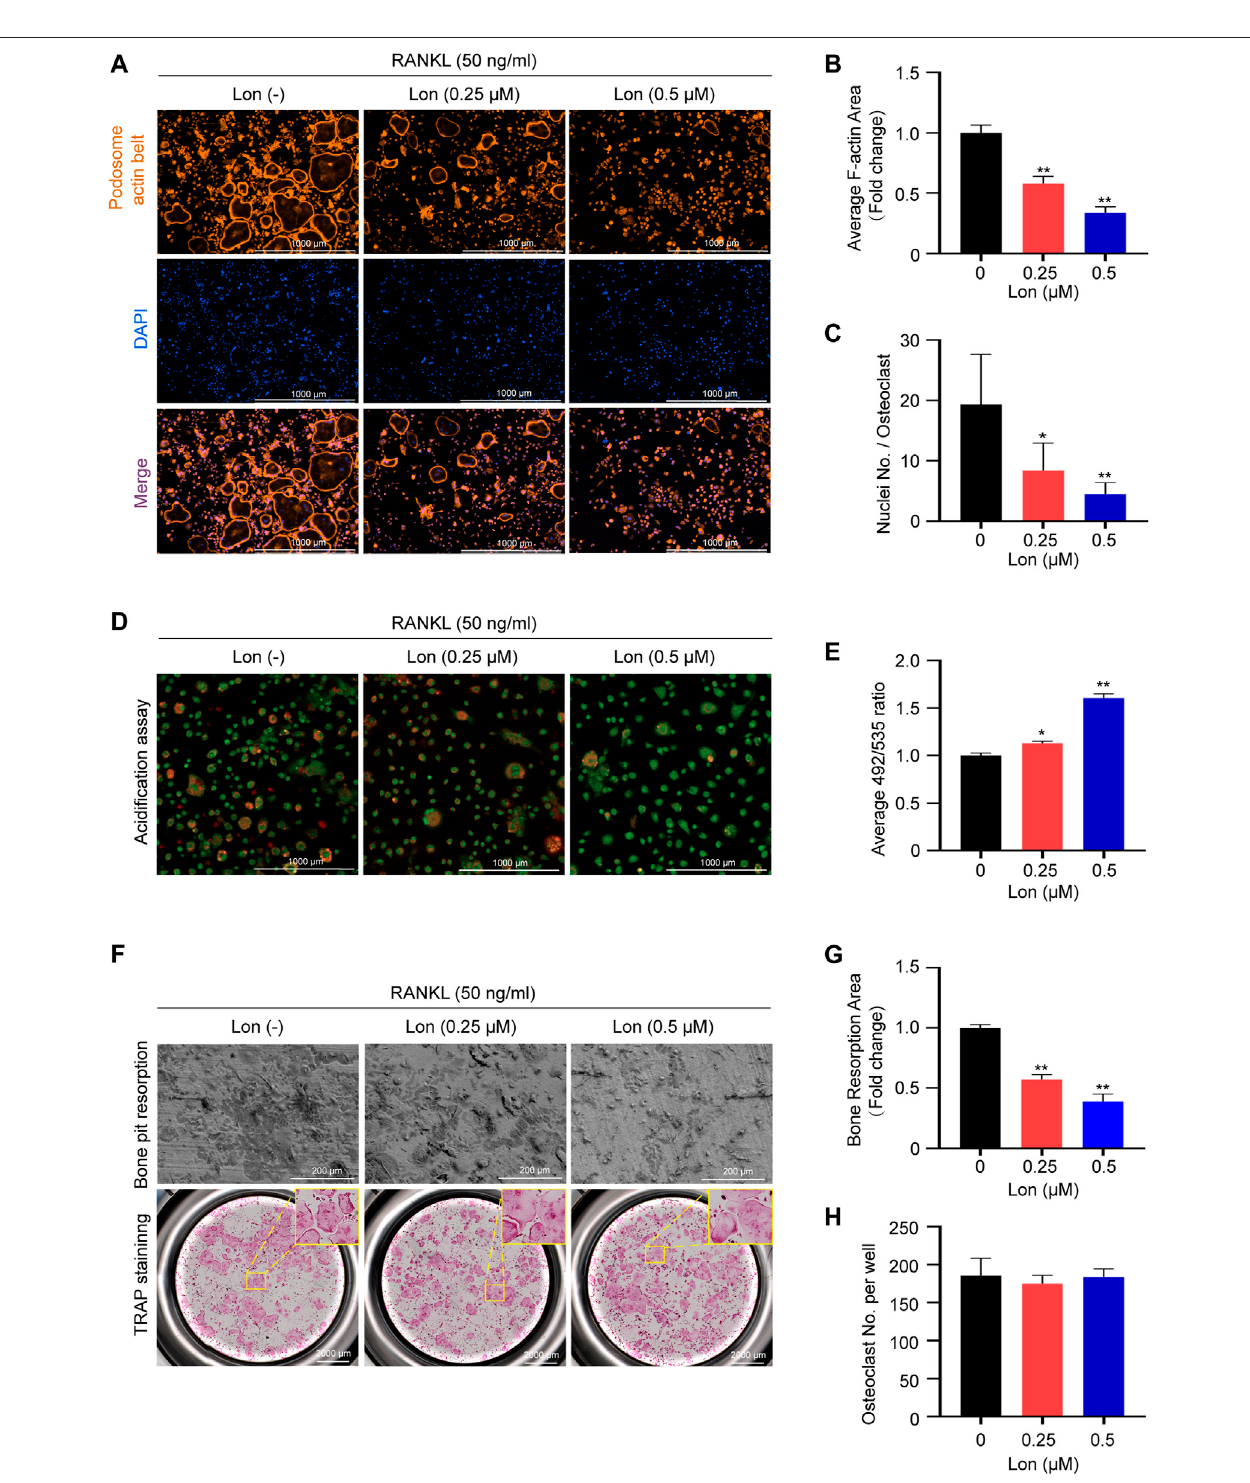
FIGURE 2 | Lon affects the bone resorptive function of osteoclasts in vitro . (A) Representative images showing the impaired podosome belts formation in osteoclasts treatedwith theindicatedconcentrationsofLon. (B) Quanti fi cation oftherelativearea ofosteoclast ( n =3per group). (C) Quanti fi cation ofthenucleinumber per osteoclast ( n = 10 per group). (D) Representative confocal microscopy images showing the impaired the acidi fi cation in osteoclasts treated with the indicated concentrations of Lon. (E) Quanti fi cation of acidi fi cation mediated quenching of acridine orange ( n = 3 per group). (F) Representative images showing the osteoclastogenesis and bone pitsresorptionineach group.Osteoclasts wereseededin bone pieces and treatedbyRANKL the indicated concentrationsofLon.Halfof the wells for each group were stained by TRAP. (G) Quanti fi cation of relative resorbed bone piece area per well in each group ( n = 3 per group). (H) Quanti fi cation of the numbersofosteoclastsperwellineachgroup( n =3pergroup).Alloftheabovedataareexpressedasthemean±SD.* p < 0.05,** p < 0.01comparedwithcontrolgroup (without Lon treatment). Lon, Lonafarnib; RANKL, receptor activator of nuclear factor- κ B ligand; TRAP, tartrate-resistant acid phosphatase.